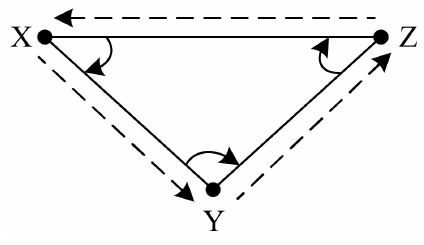
Figure 12. Left-hand rule.